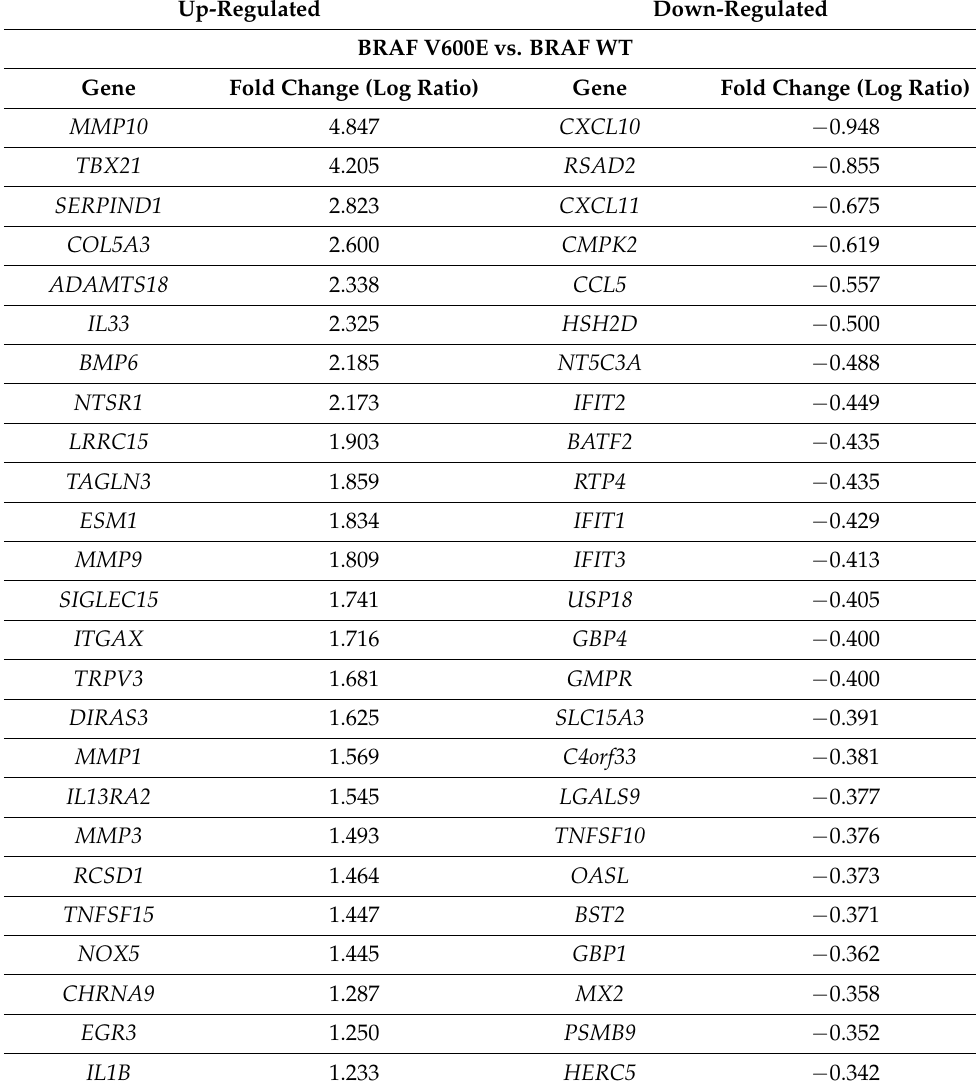
Table 2. The 25 most strongly up-regulated and down-regulated genes in THLE-2 cells. Results are presented as a fold change (log ratio) in BRAF V600E versus BRAF WT